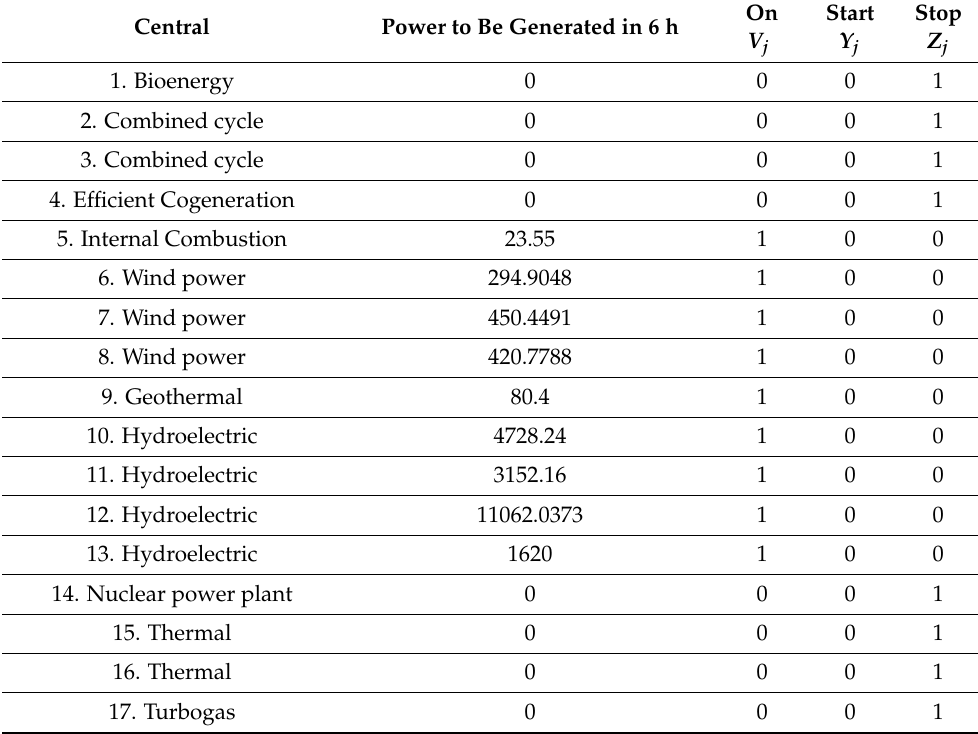
Table 3. Results of Period 1. Central Power to Be Generated in 6 h